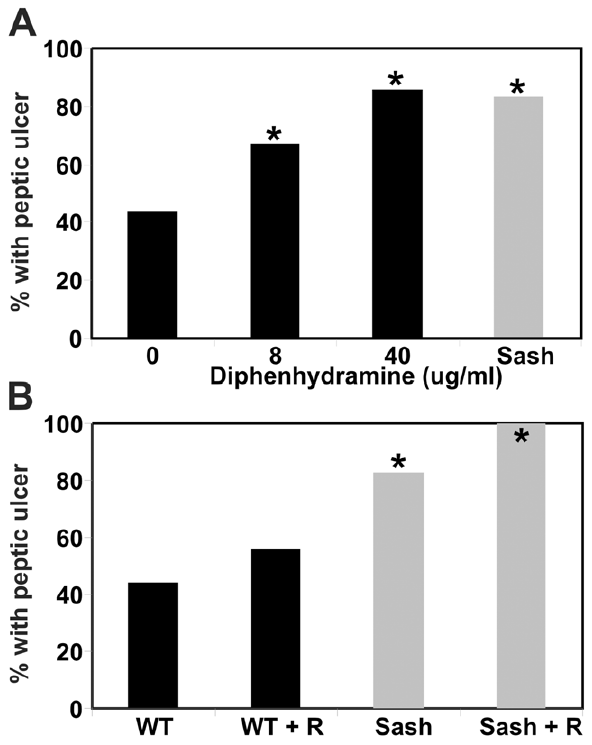
Figure 4. Effect of antihistamines on piroxicam-induced peptic ulceration. A. Treatment with the H1 receptor antagonist diphenhy- dramine increased histologically detected peptic ulcers in WT mice exposed to piroxicam (black bars; n=7–9 per group), to a level comparable in mast cell-deficient Sash mice treated with piroxicam alone (gray bar; n=18). Diphenhydramine did not affect ulcer incidence in Sash mice exposed to piroxicam (nor shown; n=6; p , 0.50). B. Treatment with the H2 receptor antagonist ranitidine (R; dose=1.8 mg/ ml in drinking water) did not affect the incidence of piroxicam-induced peptic ulcer in either WT (black bars) or Sash mice (gray bars). The